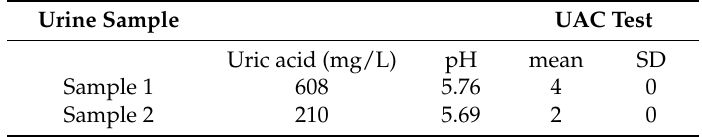
Table 2. Uric acid concentration, pH and UAC test reproducibility ( n = 5) for two different urine samples.